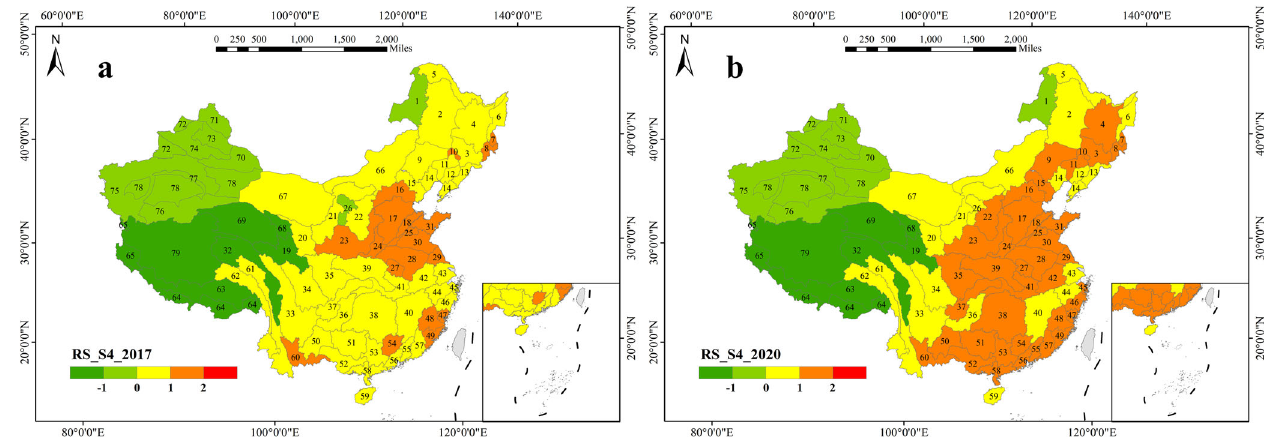
Fig. 4 Spatial distribution of risk in 2017 (a) and 2020 (b) under substitution scenario (S4). The target pesticides were assumed to be substituted by di fl ubenzuron, chlorantraniliprole, metolachlor, and sethoxydim respectively from